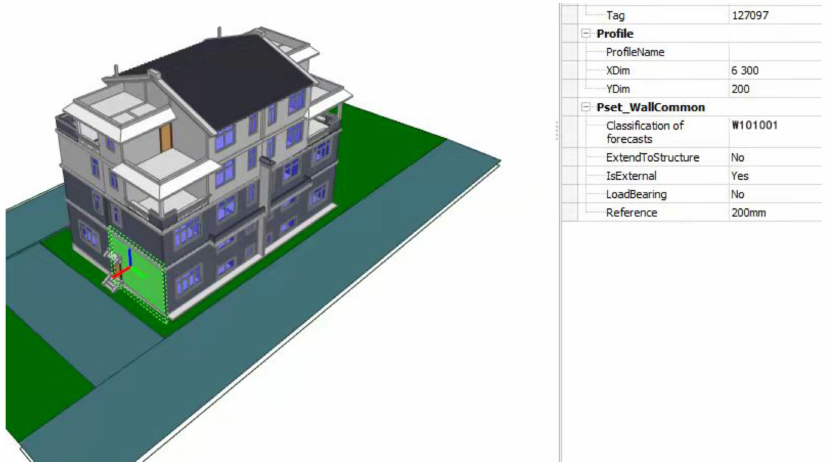
Figure 9. IFC Extension Results.